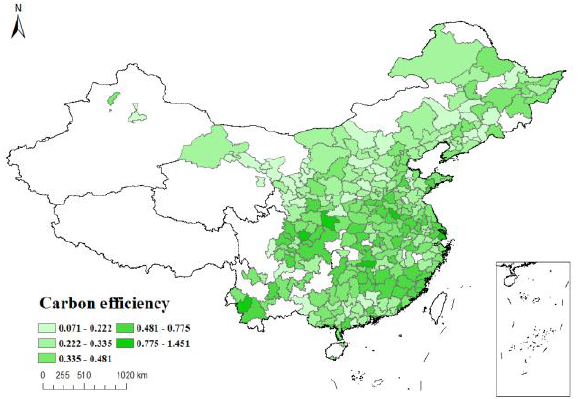
Figure 5. Carbon efficiency distribution of cities in China (2014).